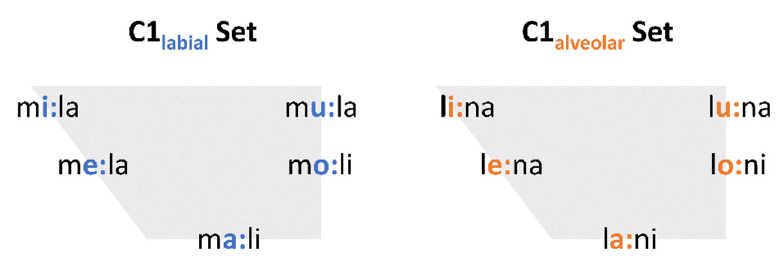
Figure 2. Target words divided into two sets depending on C1.